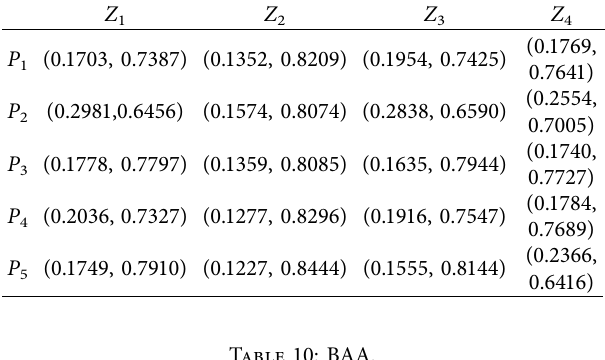
Table 9: Intuitionistic fuzzy weighted normalized performance values of alternatives.